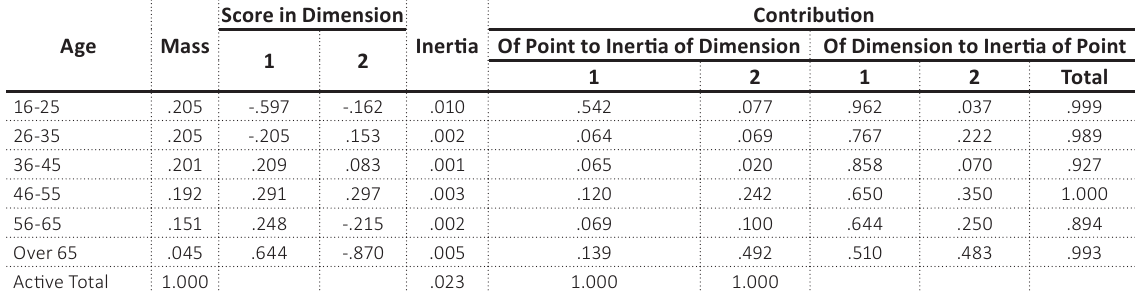
Table 6. Overview of row